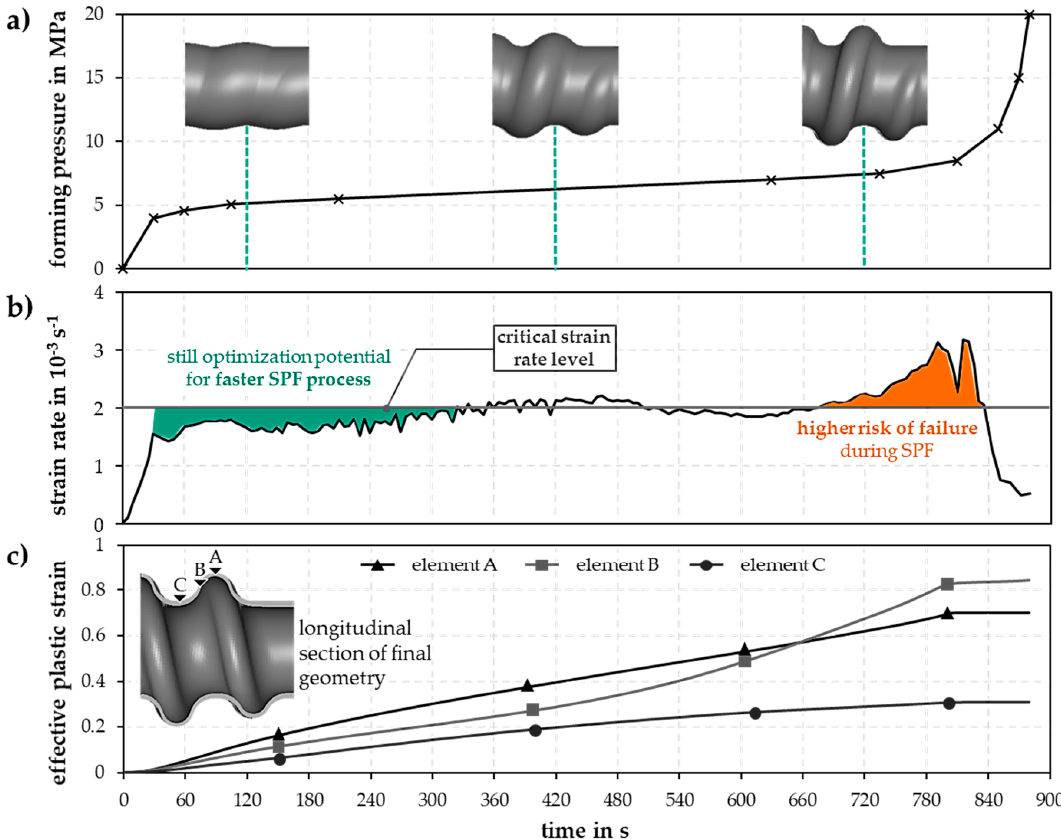
Figure 4. Results of the simulation study: ( a ) forming pressure–time diagram, ( b ) strain rate–time diagram, ( c ) effective plastic strain–time diagram.